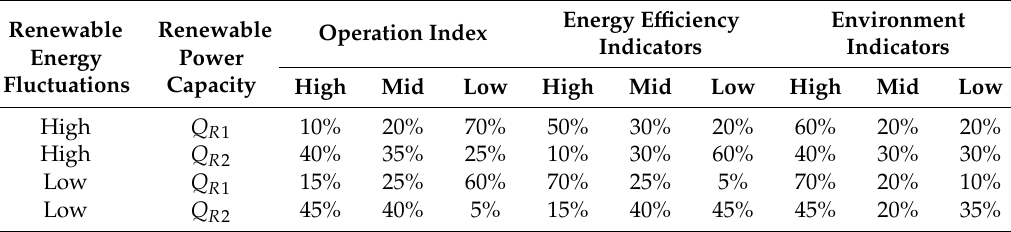
Table 4. The probability distribution of each target in the first stage of decision making.